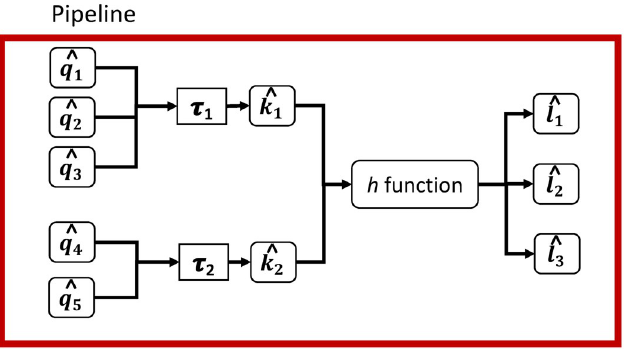
Fig 10. One arbitrary software h -function within a pipeline. Data instances ^ q transformation code τ 1 to conform to required input ^ k Outputs from the h -function are ^ ‘ with specified schema (not shown here). The pipeline framework is represented by the red box that controls execution of the h-functions and transformation codes. This is a more detailed representation of Figs 5 and